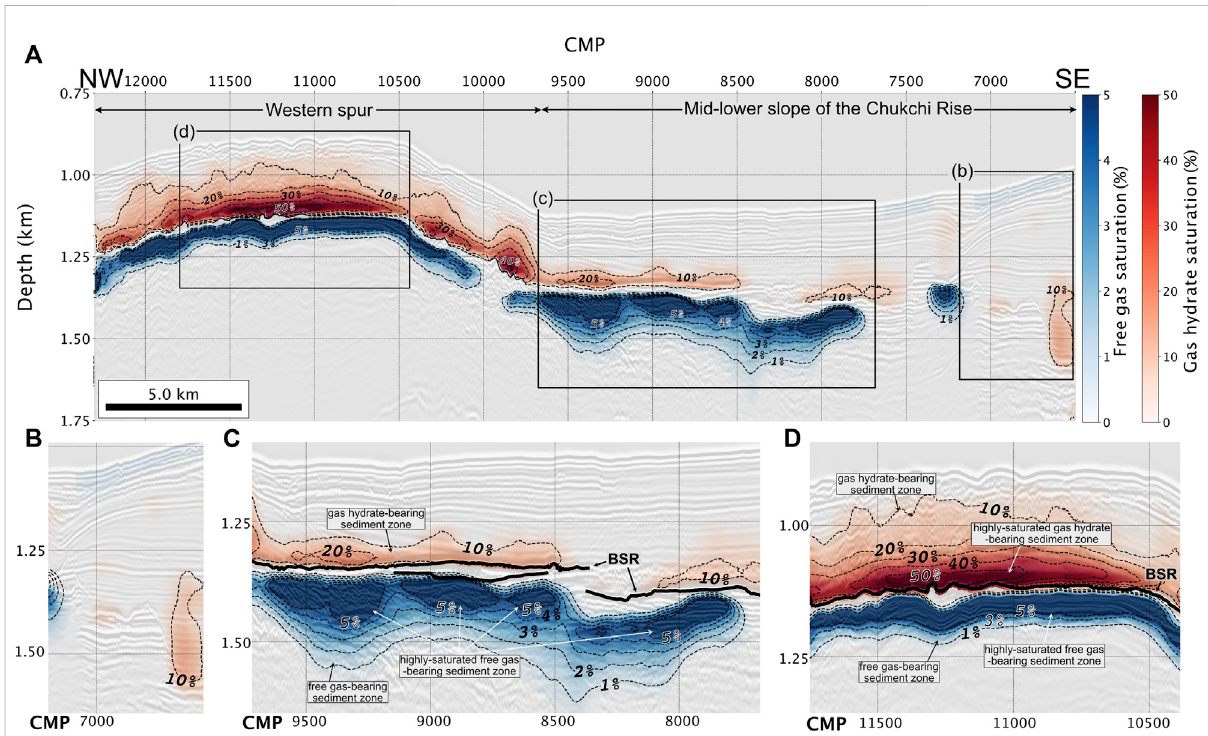
FIGURE 11 (A) Estimated gas hydrate and free gas saturation model overlaid with migrated seismic images using the IMVA of the MCS03 line. The analysis range is marked on the solid red line in Figure 1C. (B) – (D) is the enlarged velocity model: (B) absence area of the gas hydrate, (C) mid-lower slope of the western continental margin, and (D) crest of the western spur